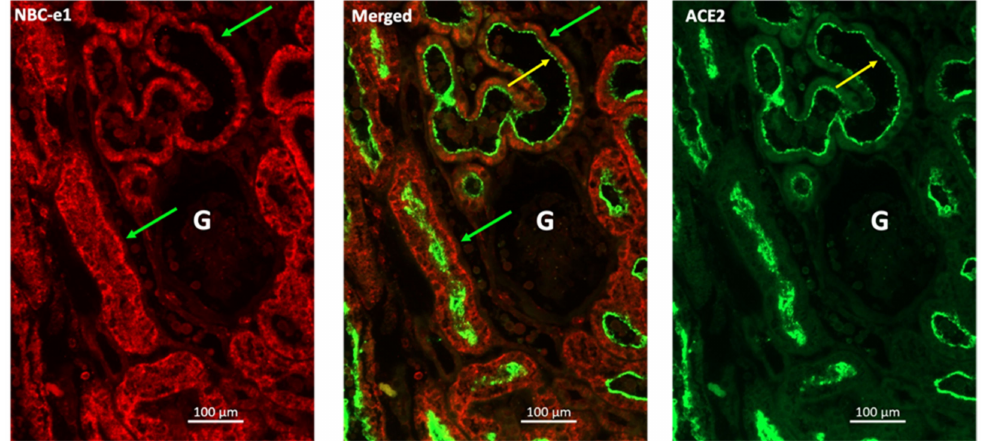
Figure 1. Immunofluorescence labeling of ACE2 in human kidney sections. Double-label immunoflu- orescence images in human kidney using antibodies against ACE2 and NBCe1. As indicated, the images depict the apical labeling of ACE2 ( right panel ; green) and basolateral labeling of NBC-e1 ( left panel ; red) in proximal tubule cells. Merged image is present in the middle panel. Green arrows indicate basolateral NBC-e1 staining and yellow arrows denote apical ACE2 staining. G represents glomerulus. ( Unpublished data from the author’s laboratory ).